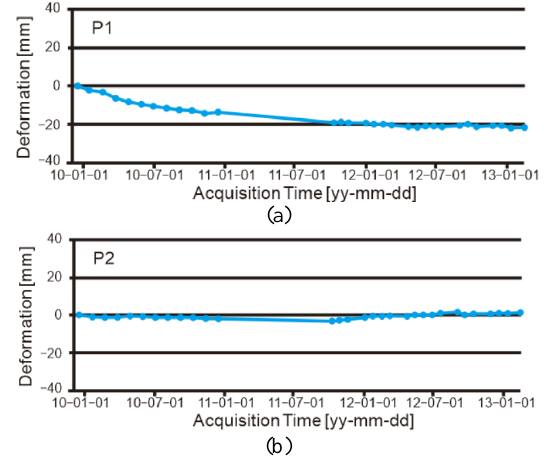
Figure 7. Deformation time series of PS points P1 and P2 due to creep and shrinkage are indicated by white crosses located in two skyscrapers (a) SWFC and (b) Jin Mao Tower in Shanghai Lujiazui